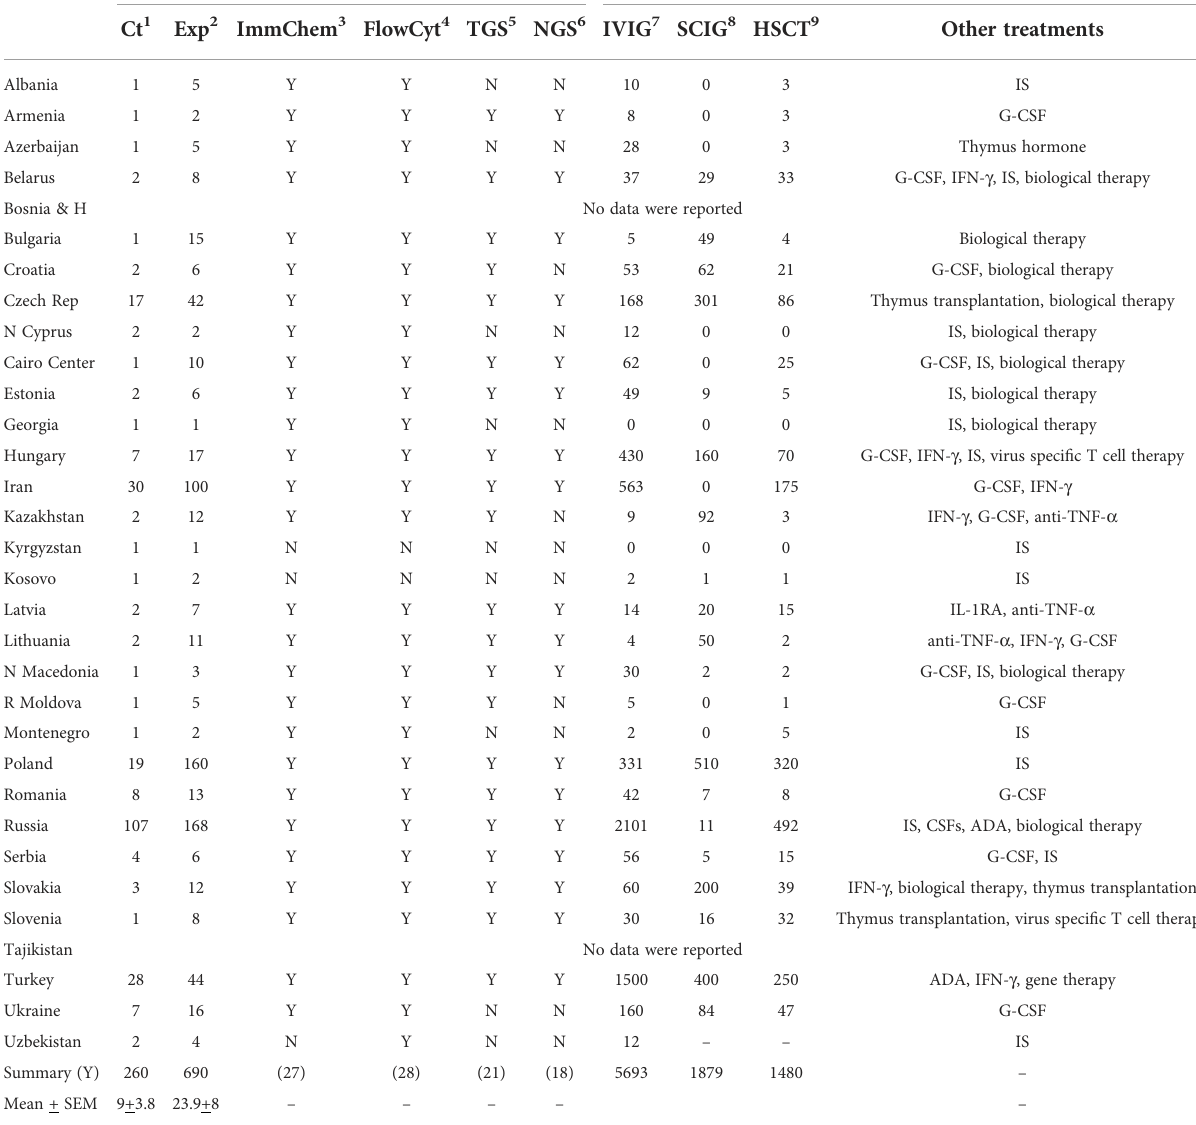
TABLE 2 Diagnostic and treatment options in JP countries/centers. Country Available diagnostic